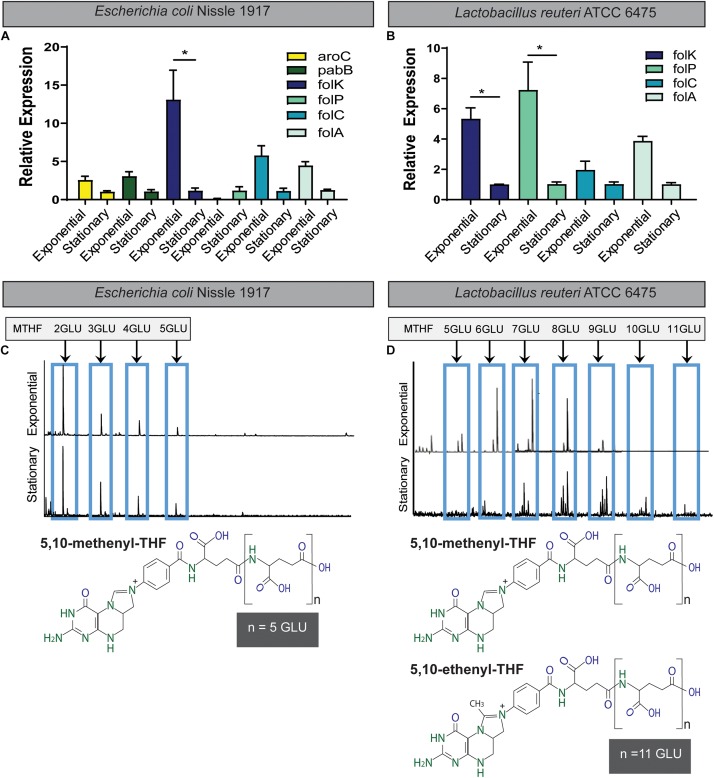
Folate synthesis during exponential and stationary growth phase by qPCR and MALDI-TOF mass spectrometry. Expression of folate synthesis genes at exponential and stationary phase growth in (A)
Escherichia coli Nissle 1917 and (B)
Lactobacillus reuteri ATCC PTA 6475 as determined by qPCR. aroC is involved in chorismate synthesis; pabB in pABA synthesis; folP, folC, and folA in pterin and folate synthesis. Expression is normalized to 16S rRNA. One-way ANOVA with Bonferroni post hoc test. ∗p < 0.05 (n = 3 biological replicates). Differential glutamylation profiles of folates determined by MALDI-TOF mass spectrometry for (C)
E. coli Nissle 1917 and (D)
L. reuteri ATCC PTA 6475. L. reuteri produces both the 5,10-methenyl THF as well as the 5,10-ethenyl THF form with + 14 glutamate (GLU) residues. Blue boxes highlight the peaks which represents MTHF + nGLU.